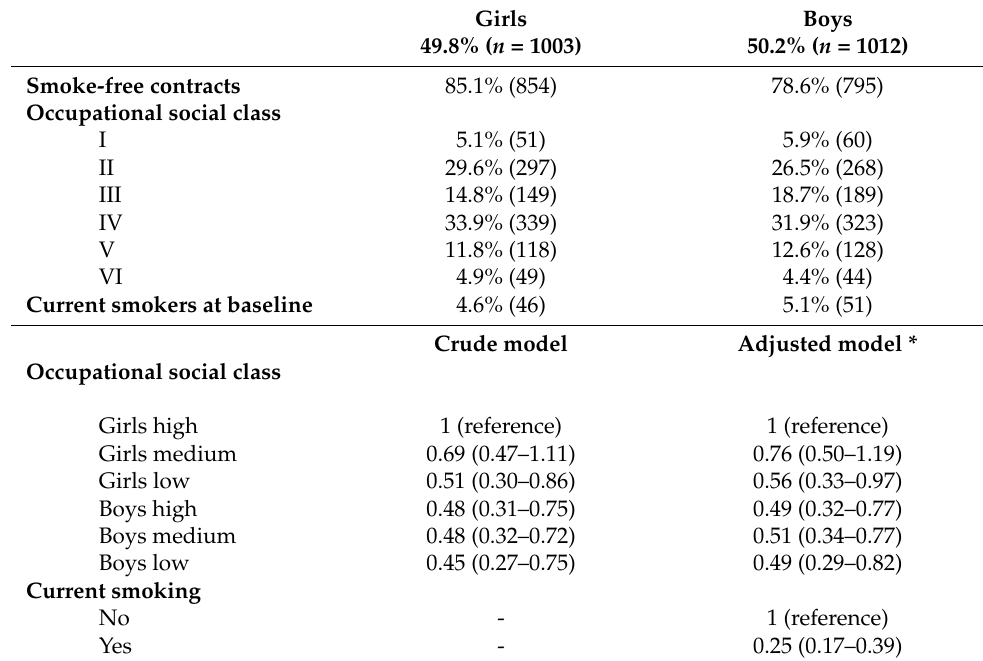
Table 1. Descriptive statistics and analyses of joined effects of gender and OSC on the odds ratio (95% CI) of having a smoke-free contract.